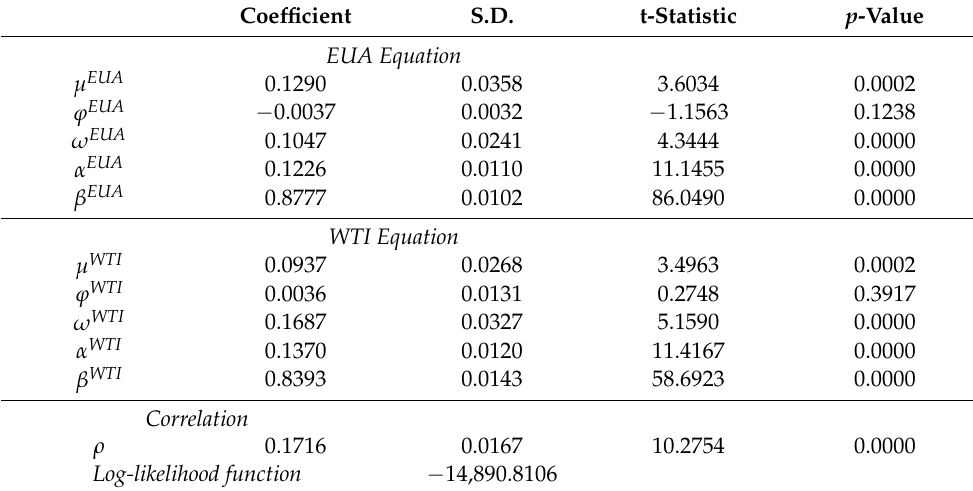
Table 3. Estimated results of the bivariate GARCH-CCC model.